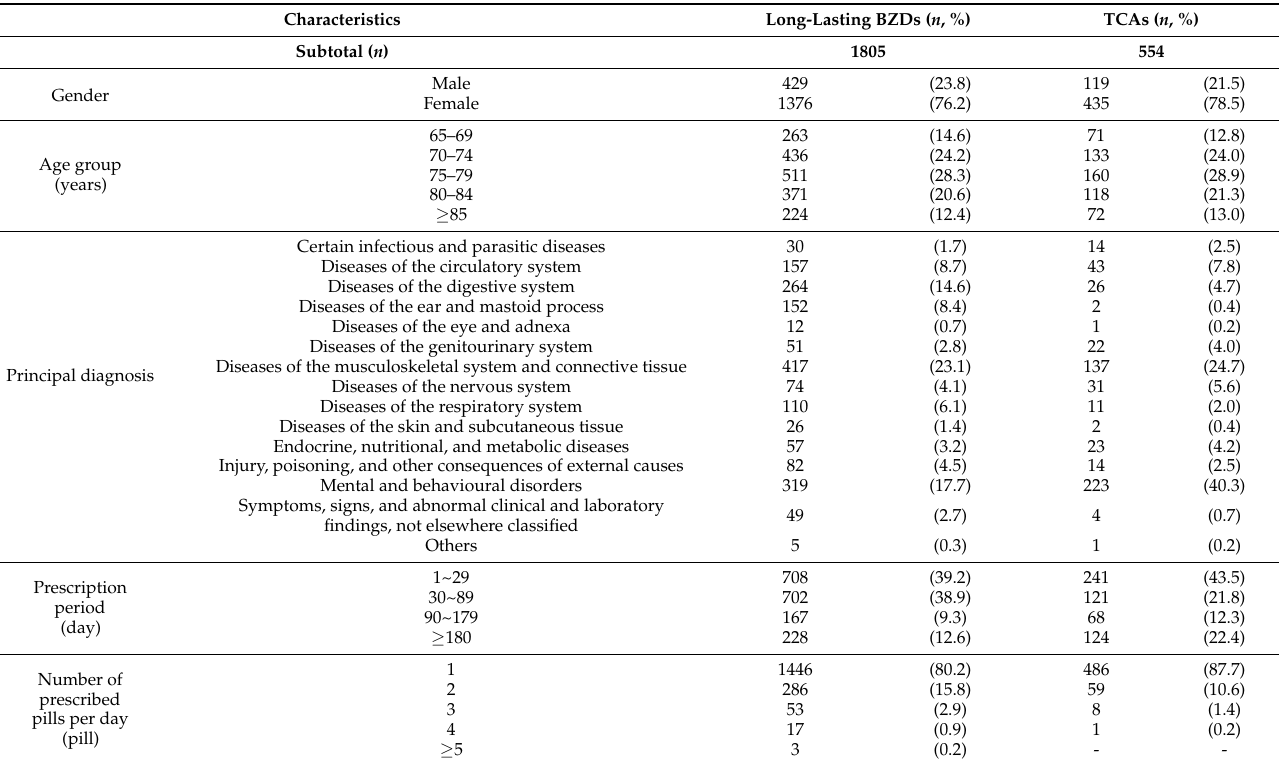
Table 1. Participant Characteristics ( n =